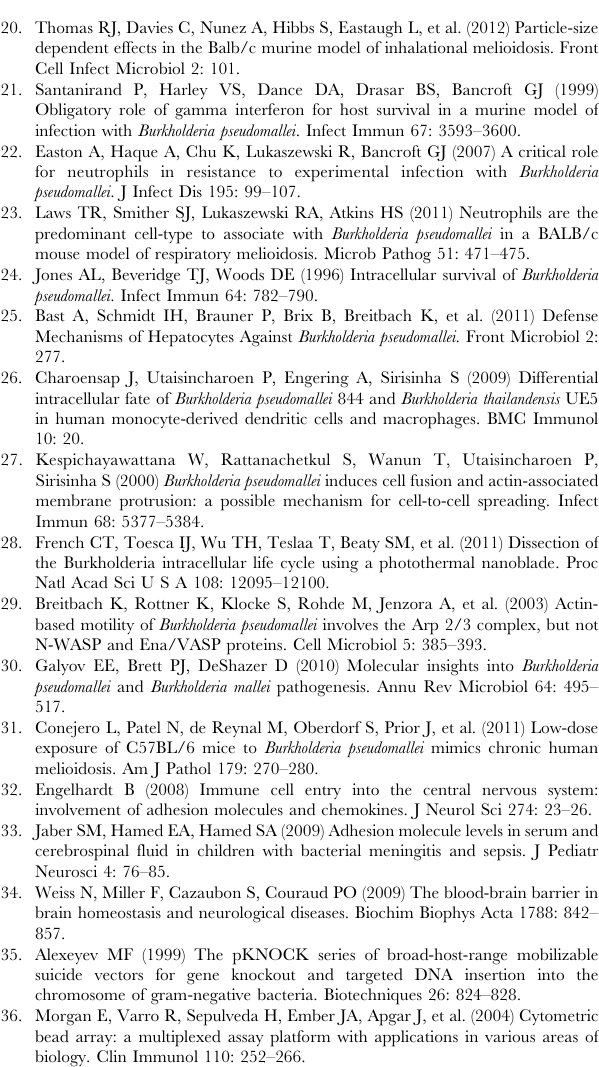
Table S3 Summary of the characteristics of melioidosis progression during intravenous infection. Table S4 Summary of the characteristics of melioidosis progression after adoptive